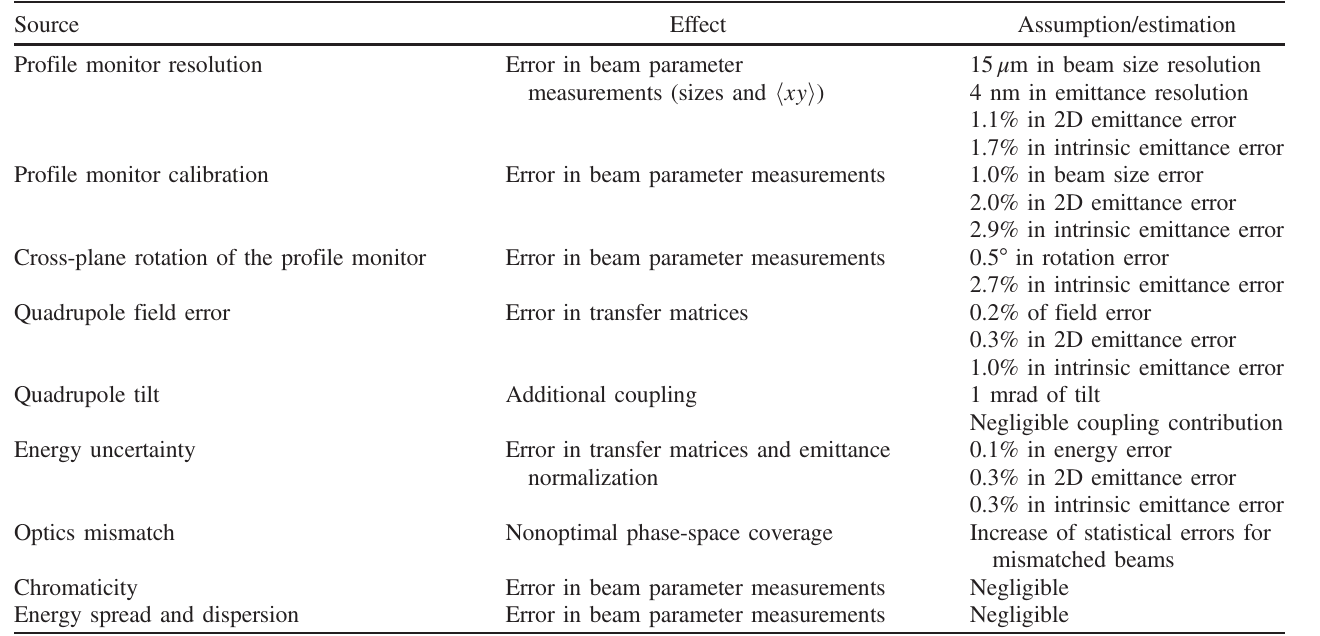
TABLE I. Summary of systematic errors for the 4D measurement at the SITF.